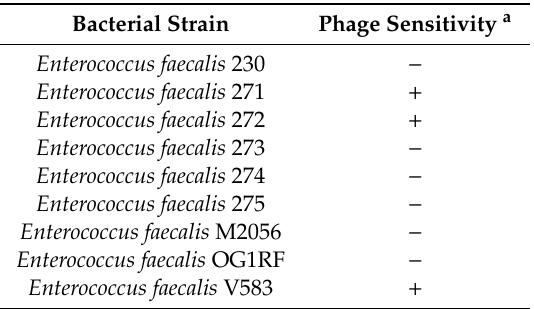
Table 1. Lytic activity of vB_EfaS-271 against tested E. faecalis